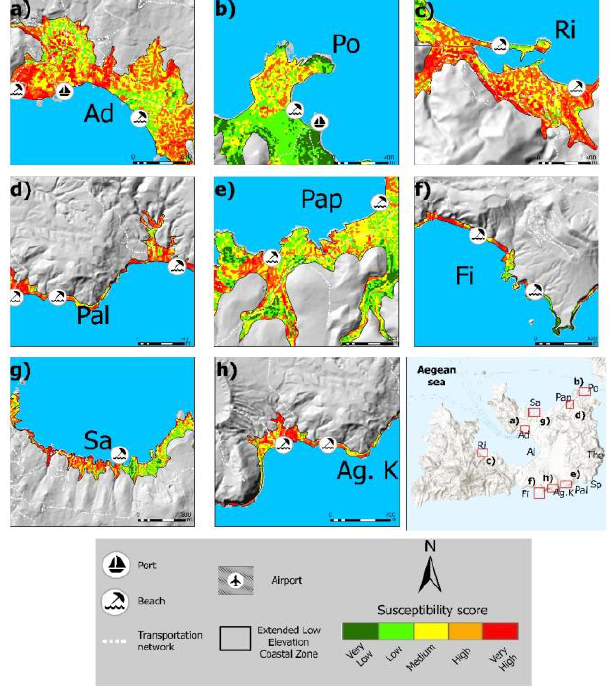
Figure 14. Map illustrating areas ( a – h ) prone to AHP multi-hazard in Milos Island. Ad: Adamas, Po: Posidonia, Ri: Rivari lagoon, Pal: Palaiochori, Pap: Papafragas, Fi: Firiplaka, Sa: Sarakiniko and Ag.K: Agia Kiraki. Green color illustrates the areas with the lower susceptibility score and red color the higher, respectively.